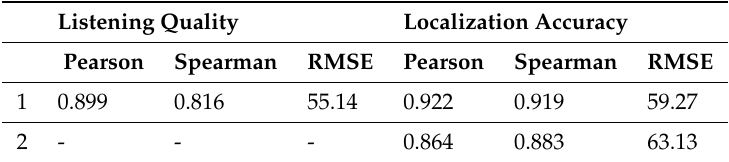
Table 6. Correlation between subjective MUSHRA and objective AMBIQUAL results from experiments 1 and